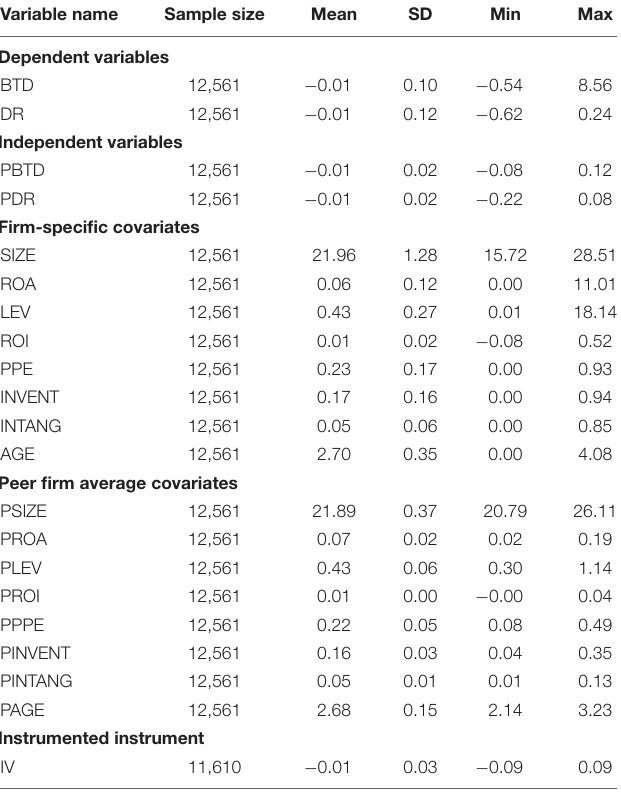
TABLE 1 | Summary